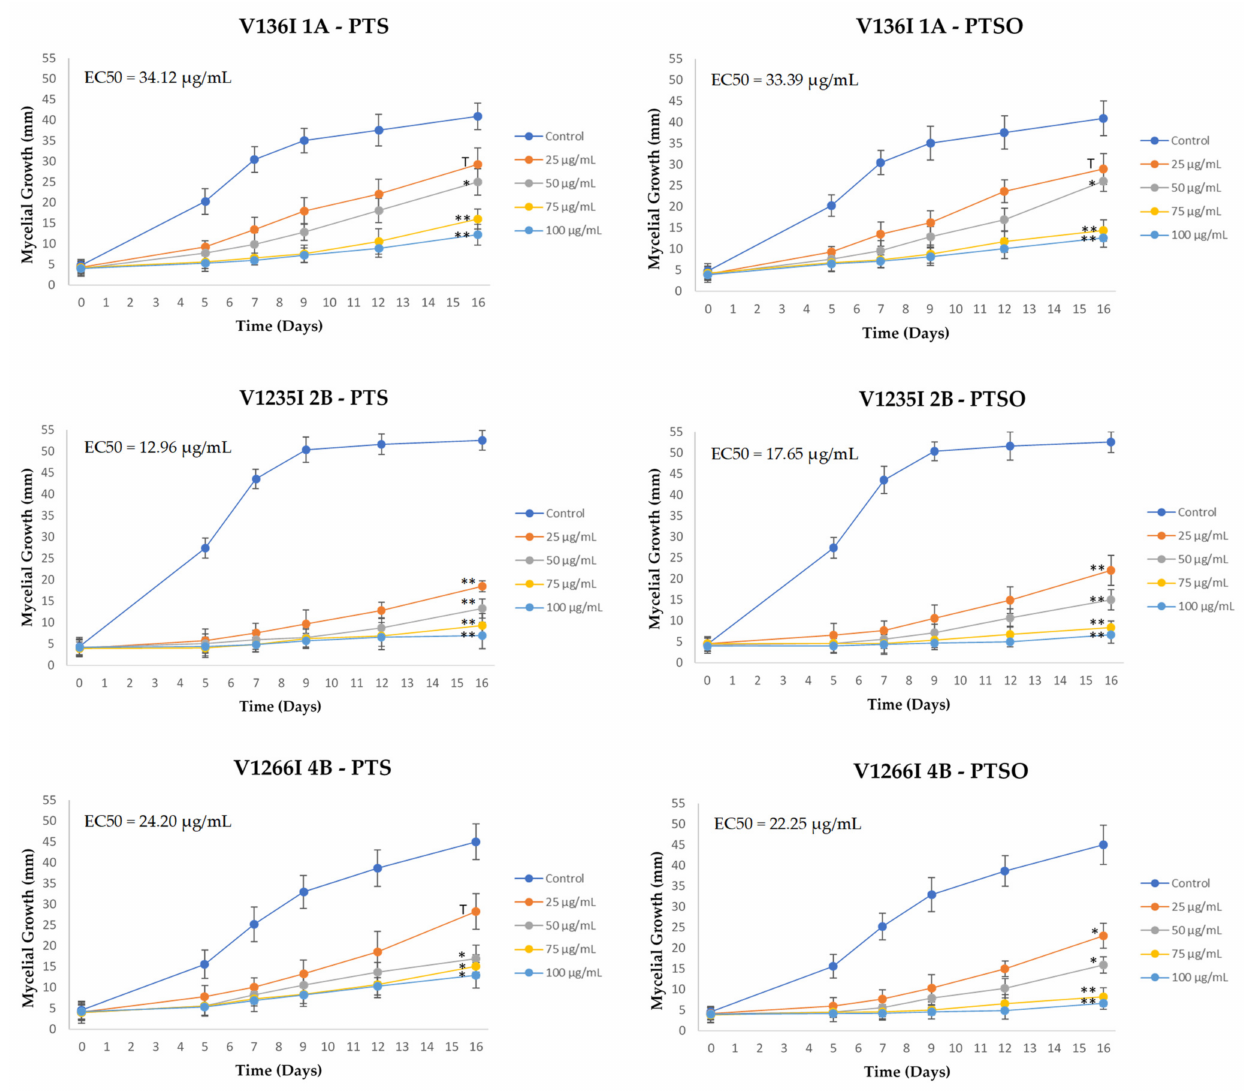
Figure 3. Mycelium Growth Curves of Verticillium dahliae isolates at different concentration of PTS and PTSO: control group; 25; 50; 75 and 100 µ g/mL. Values are means with SD in bars. T p < 0.1; * p < 0.05; ** p < 0.01 respect to control. EC50 values have been calculated for each V. dahliae isolate and each organosulfur